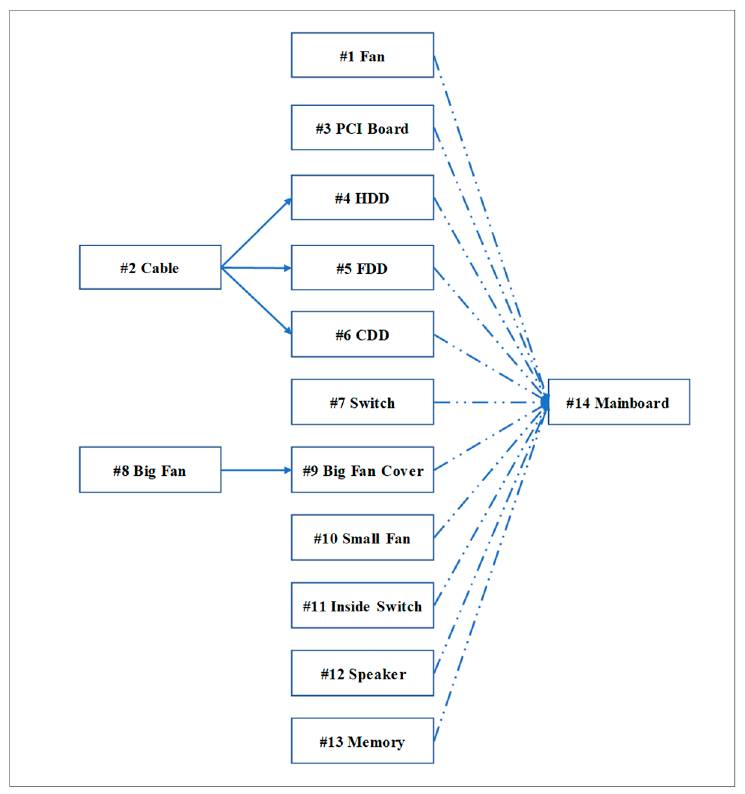
Figure A1. The precedence relationships of a computer [26].